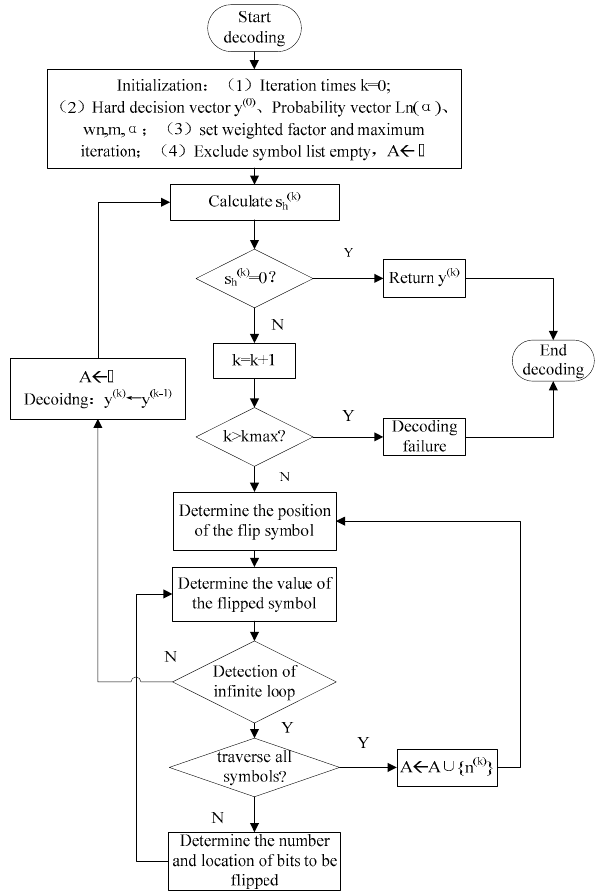
Figure 1. Flow chart of LUDMSMWSF algorithm.